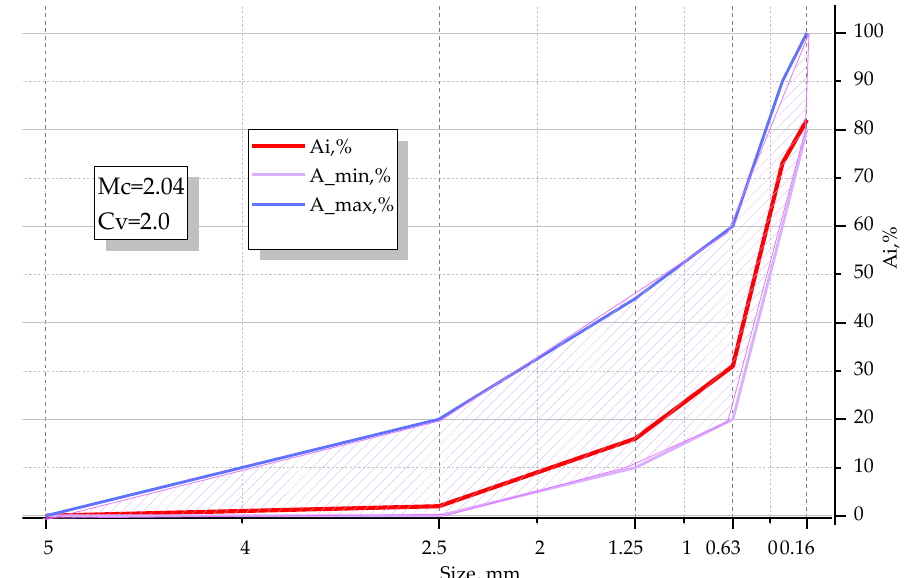
Figure 1. Granulometric curve for fine aggregates (Ai — total residues on a sieve of given cell size, Ai_max, Ai_min — maximum and minimum values of total residues).